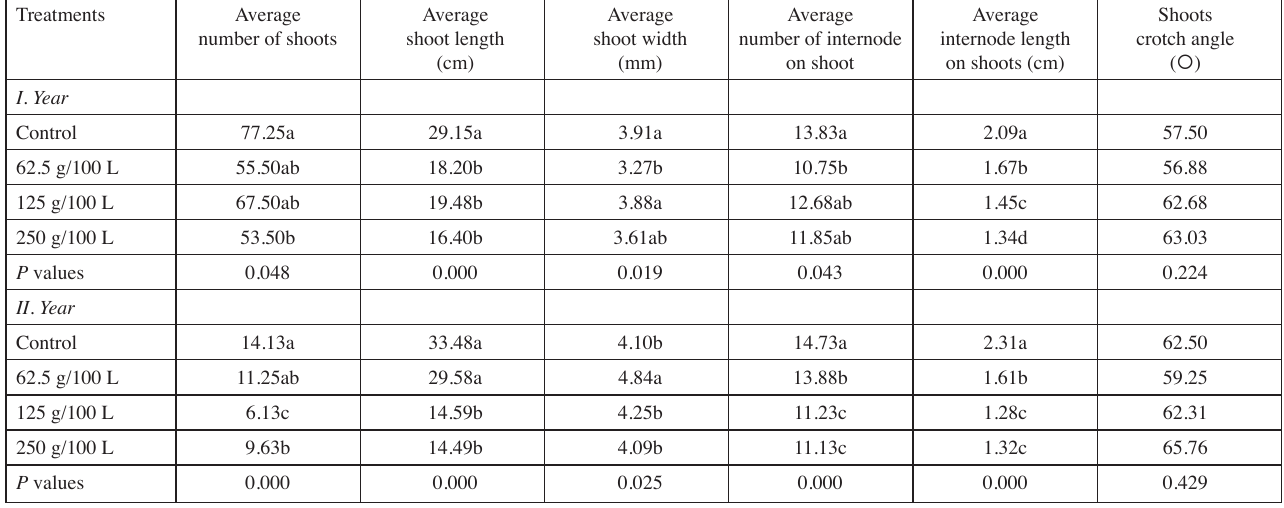
Tab. 2: The effect of Pro-Ca dosage on shoot growth in the ‘Starcrimson’ apple cultivar Treatments